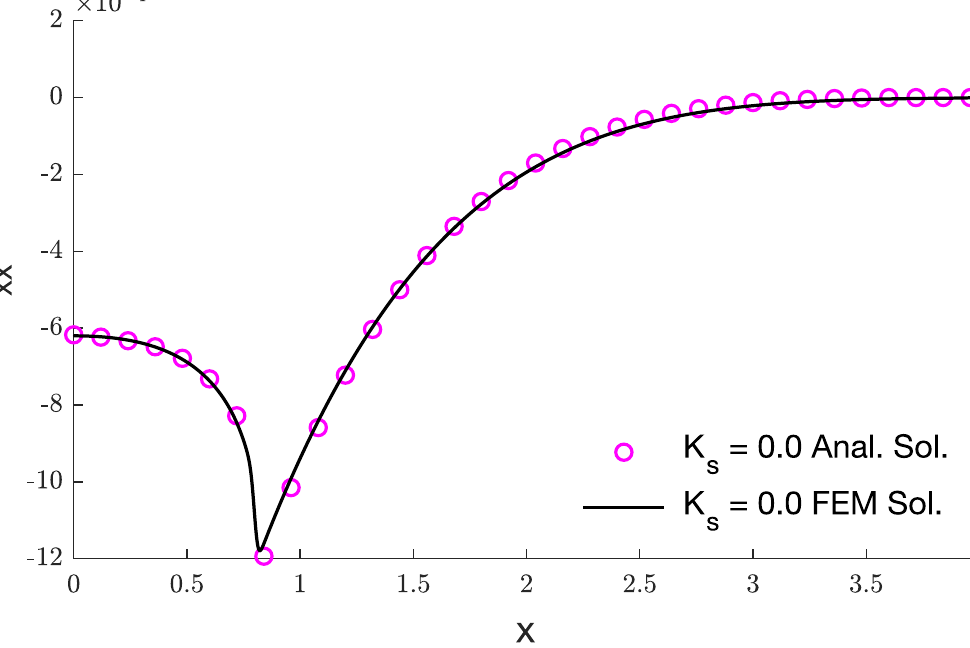
Figure 16. The study on stress comparison.